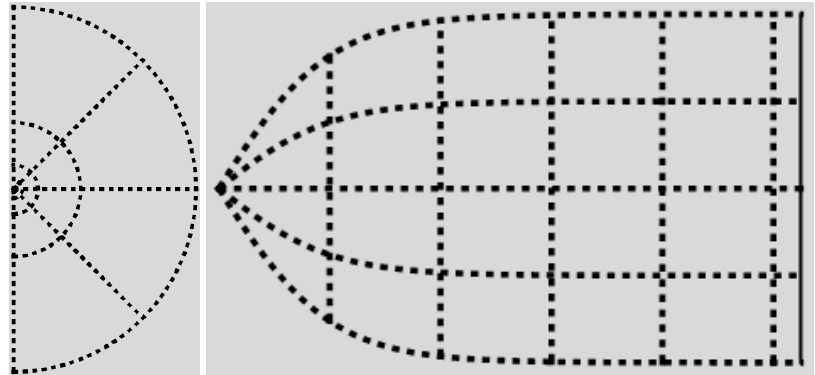
Figure 4. The canonical ( p, q ) -domain is the region between the graphs of q and the lines p = 0 and p = arcsinh T . On the left , ( t, φ ) are dimensionless radial and azimuthal coordinates. On the right , the canonical ( p, q ) -coordinates are plotted as Cartesian coordinates, with p on the horizontal axis. Recall Equation (28), and compare with Figure